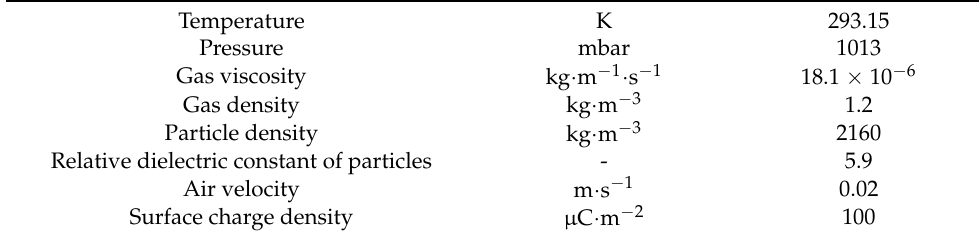
Table 5. Simulation